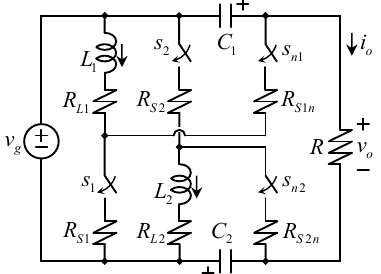
Figure 7. Proposed circuit with series losses through inductors and transistors.